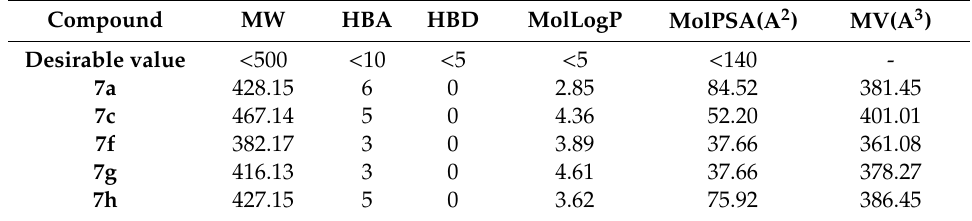
Table 3. Molecular properties of selected compounds.